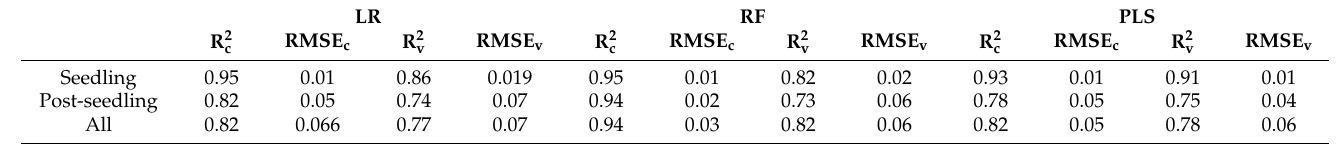
Table 8. Prediction results of LR, RF, and PLS with the optimal normalized difference texture index subset across all different growth stages.